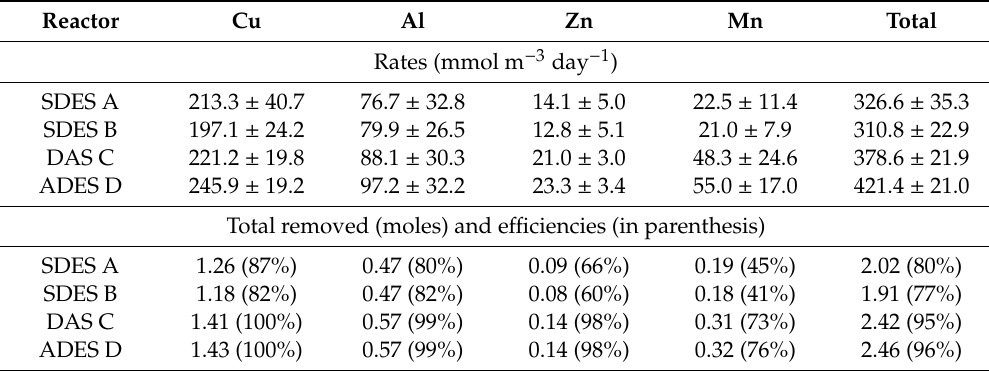
Figure 3. Metal concentrations: ( a ) Cu; ( b ) Al; ( c ) Zn; ( d ) Mn.